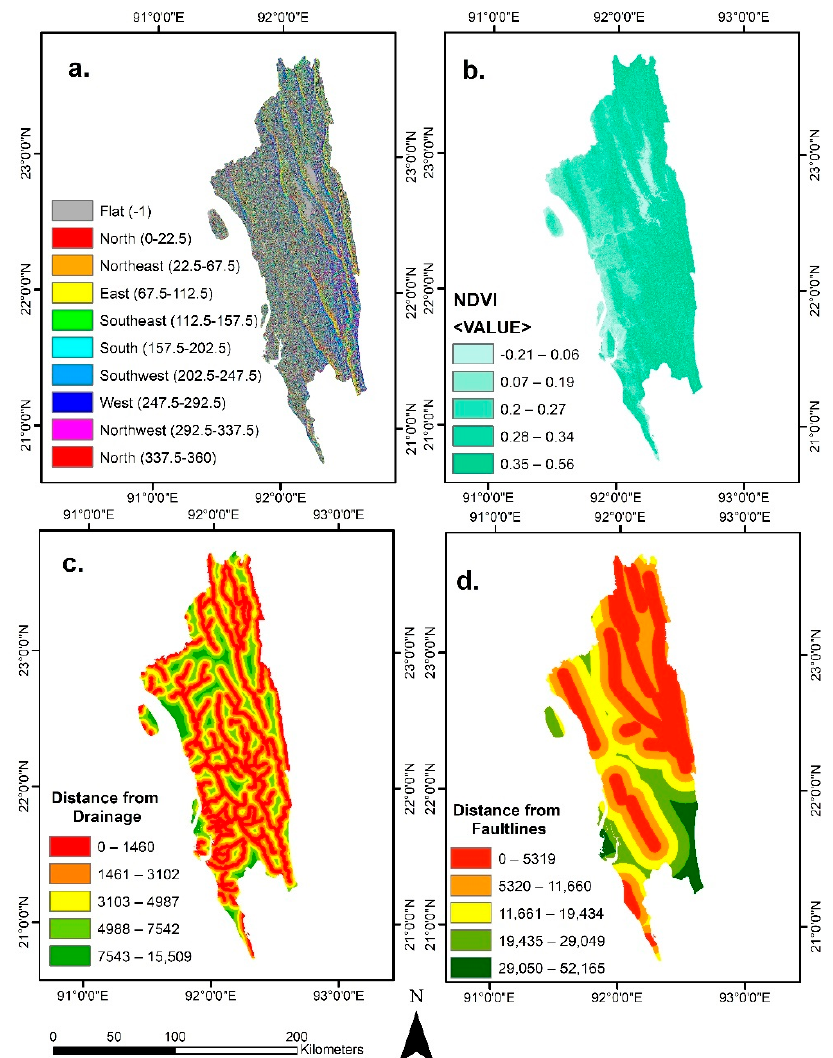
Figure 5. Predisposing Factors of Landslides. ( a ) Aspect; ( b ) NDVI; ( c ) Distance from Drainage Networks; ( d ) Distance from Fault Lines.